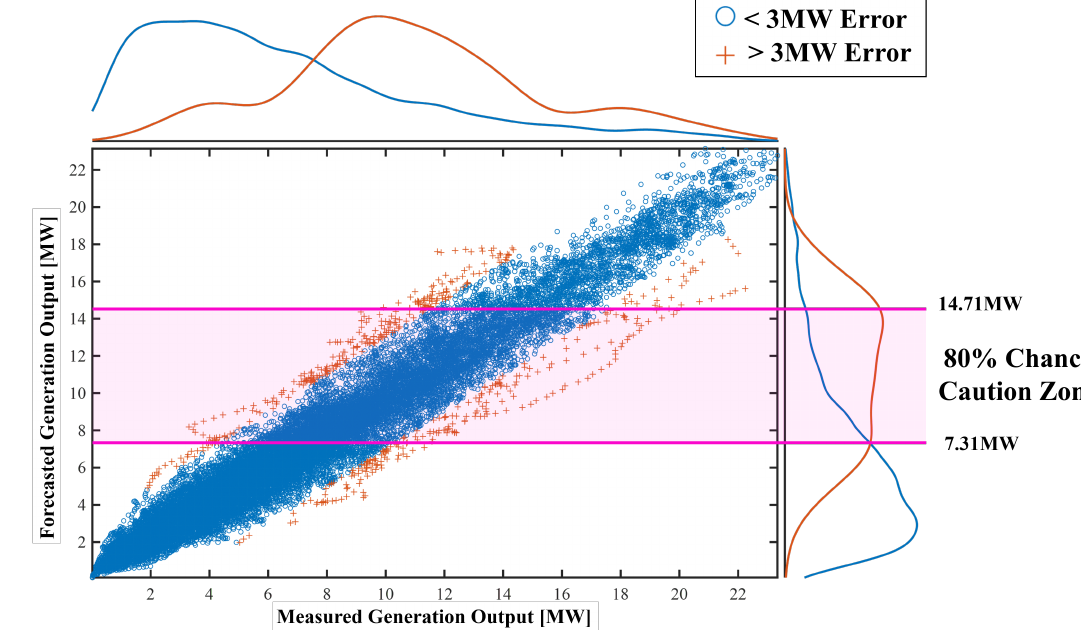
Figure 7. Joint distribution of measured and forecast generation output for case 2 in Table